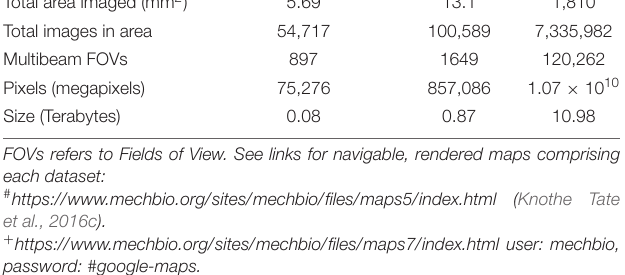
TABLE 1 | Dataset metrics from three generations of mSEM maps from three different human hip samples obtained with IRB approval. Data